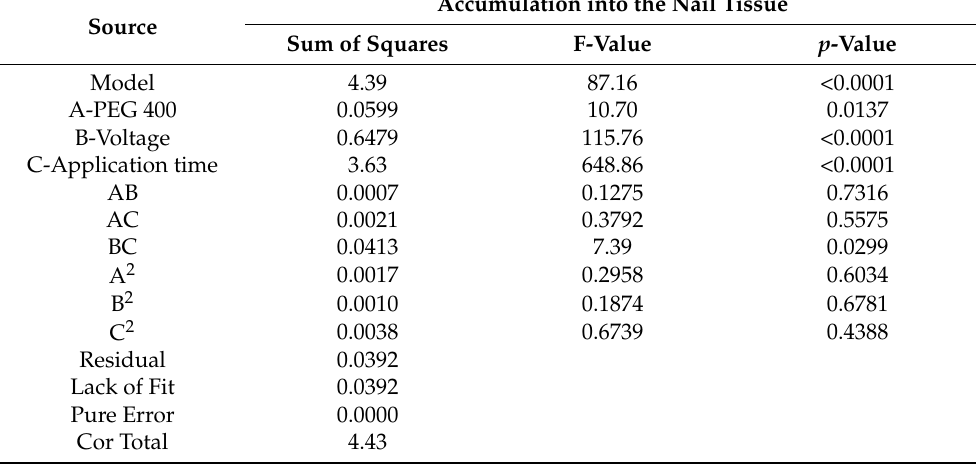
Table 5. ANOVA data generated by the software for quadratic model on drug accumulation into the nail